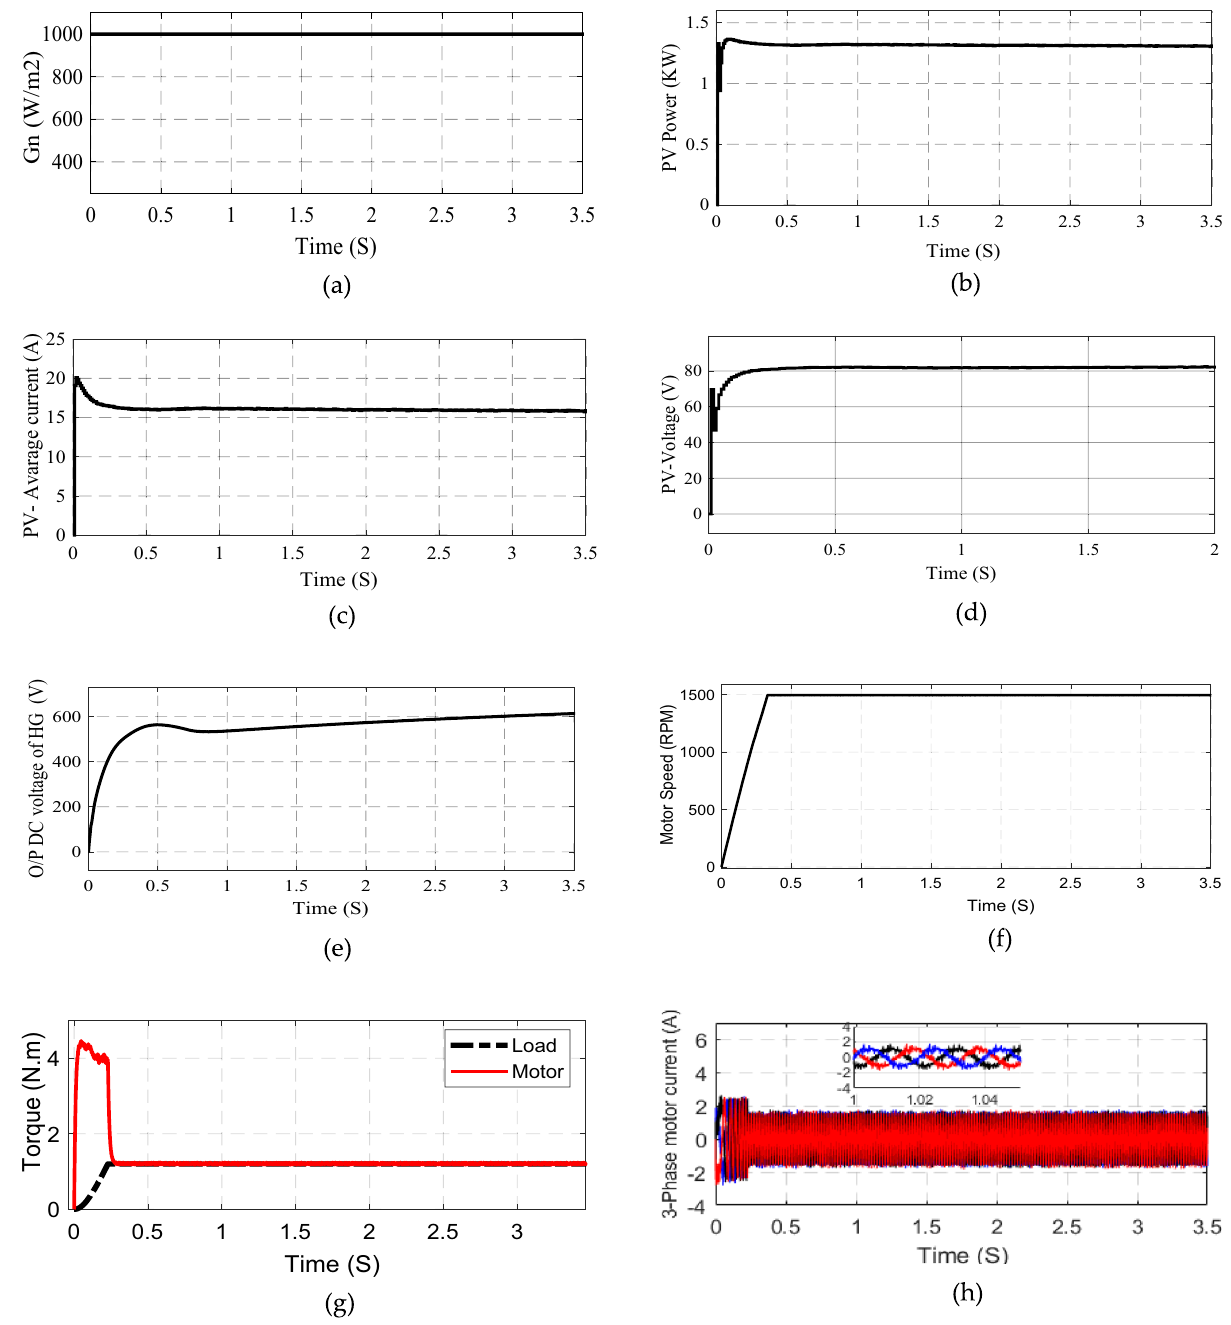
Figure 9. System starting response ( a ) Irradiation ( b ) PV-power (V) PV current ( d ) PV-voltage ( e ) Voltage after high gain cell ( f ) Motor speed ( g ) Motor and load torque ( h ) Motor phase